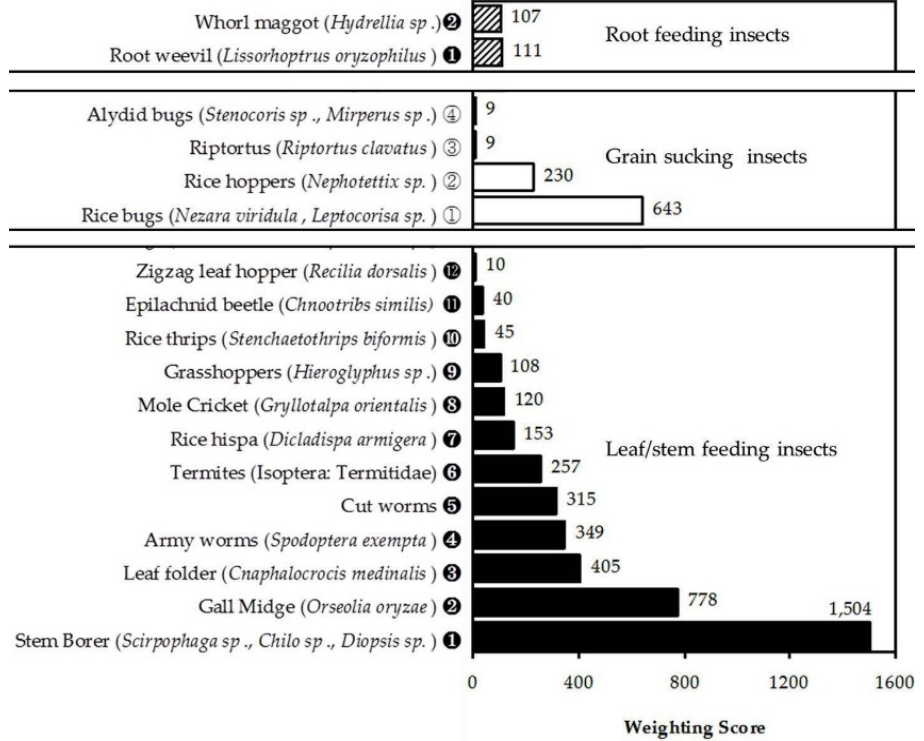
Figure 4. Farmer ranking of rice insect pests by category and according to importance on rice.